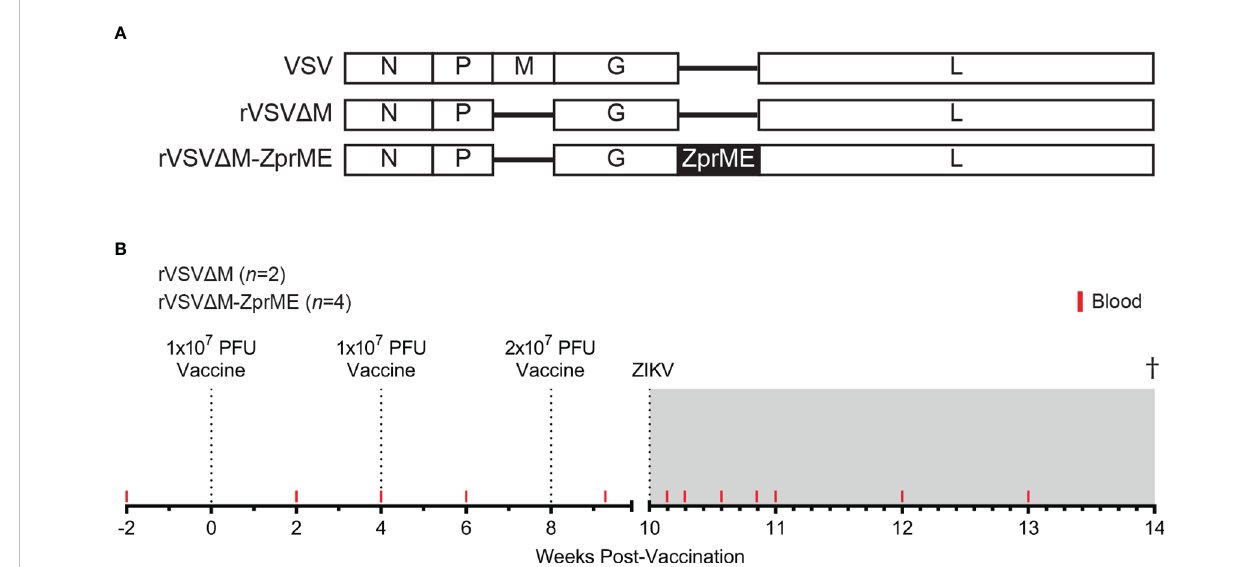
FIGURE 1 Vaccine vector schematic and NHP vaccine study design. (A) Schematic showing the VSV (-) strand RNA genome and recombinant VSV vaccine constructs. The VSV M gene is deleted from the rVSV vector (rVSV D M). The rVSV D M-ZprME construct includes a ZIKV pre-membrane envelope (prME) transgene (B) NHP vaccine study design and blood sample collection time-points. Six female pigtail macaques were enrolled in the study and received intramuscular injections of either rVSV D M-ZprME ( n =4) or rVSV D M ( n =2) in a prime-boost strategy at Weeks 0, 4 and 8 and are indicated by the dotted lines. The second boost immunization given at week 8 was administered at twice the original dose. All animals were subcutaneously challenged at 10 weeks with total dose of 5×10 5 PFU ZIKV FSS13025. The study ended 27-30 days post-challenge. The ZIKV phase is the shaded grey